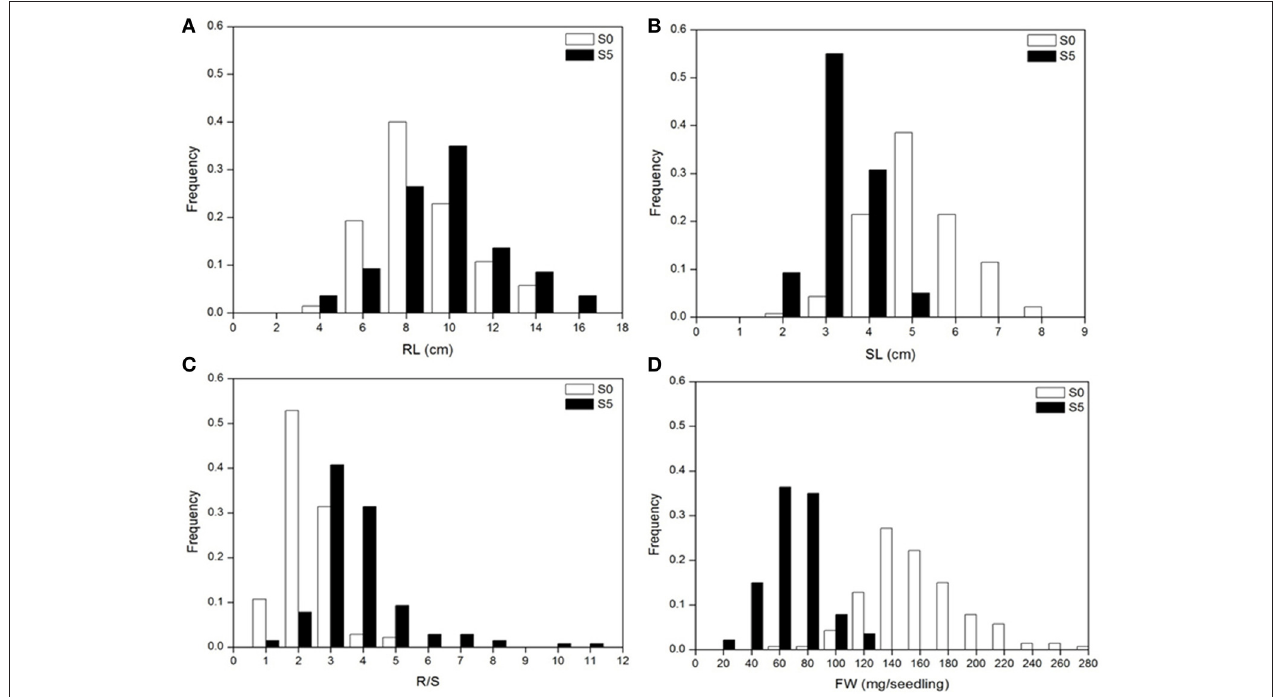
FIGURE 1 | Distribution of seedling traits phenotyped under normal (S0) and water stress (S5) conditions. (A) , root length (RL); (B) , shoot length (SL); (C) , root to shoot length ratio (R/S); (D) , fresh weight (FW).